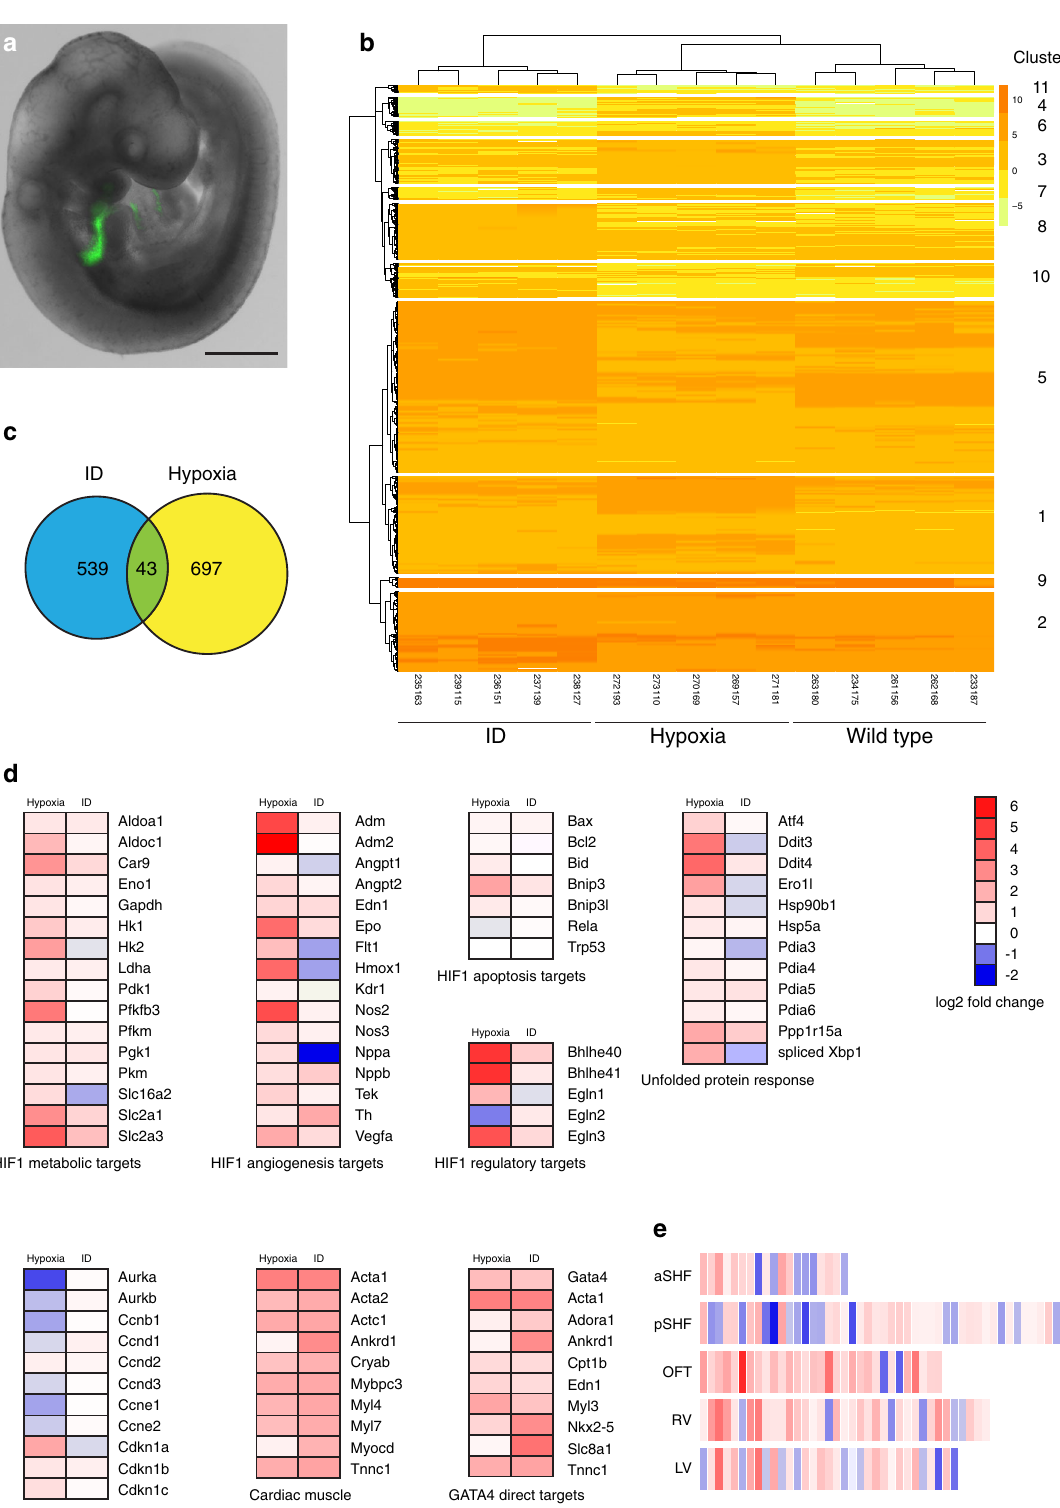
DE transcripts from ID embryos with data from single cell transcriptomic analysis of the cardiogenic regions of E9.25 embryos 36 . The ID transcriptome was most closely related to the OFT cluster, rather than to the aSHF cluster ( P = 3.5798 × 10 − 6 , Fig. 3e). Premature differentiation of the aSHF is a feature of several mouse knockout models with similar cardiac defects to our ID